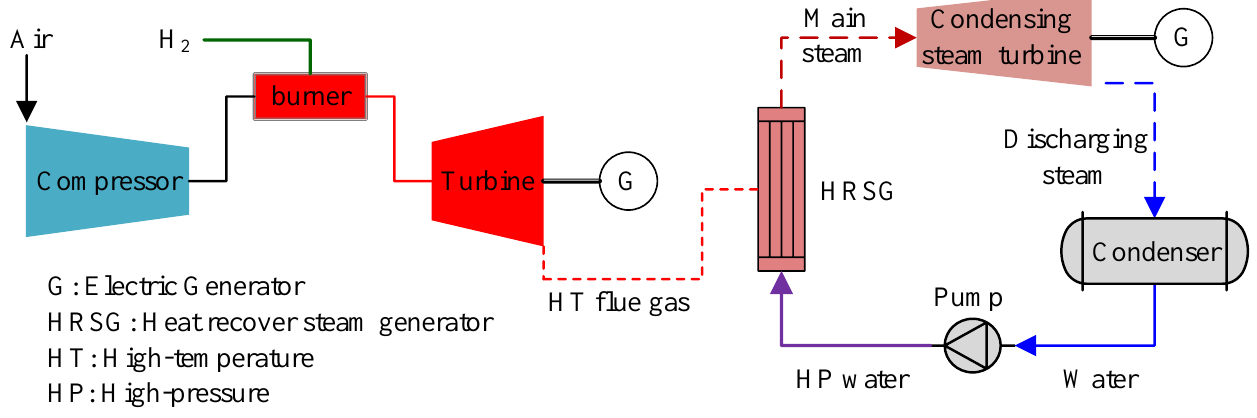
Figure 2. Process flow diagram of hydrogen-fueled CCGT.